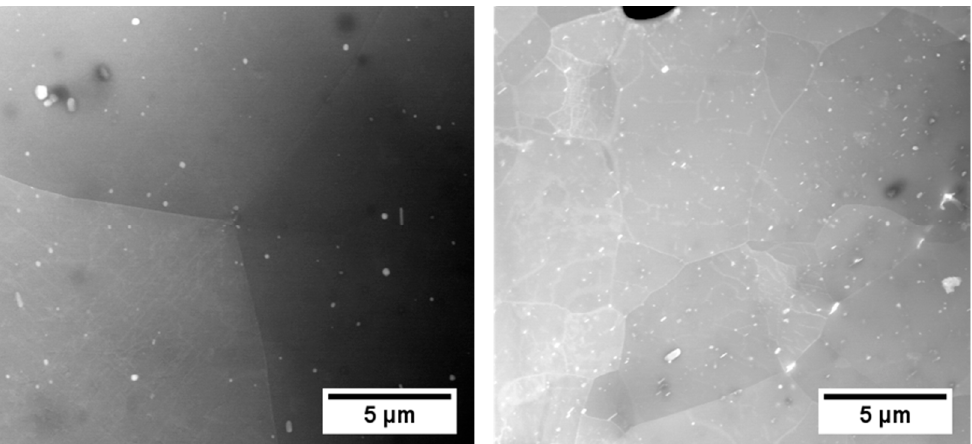
Figure 14. STEM HAADF images of EN-AW-6016 + 100 at.-ppm Sn ( a ) and EN-AW-6061 + 100at.-ppm Sn ( b ). Both samples were solution annealed at 560 °C (6016) or 570 °C (6061) and quenched via air cooling. The number of visible IMPs is much higher for EN-AW-6061 ( b ), due to higher Fe, Mn, and Cr content.